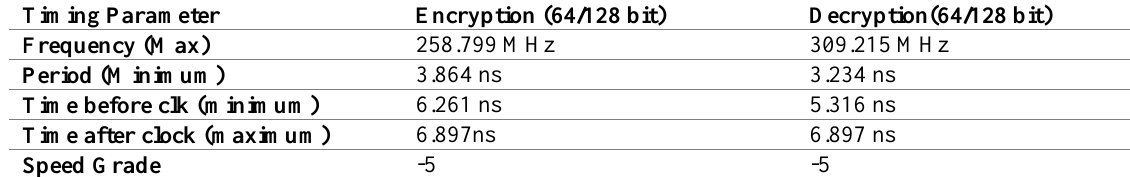
Table 5 Timing summary for smart grid TACIT encryption and decryption logic